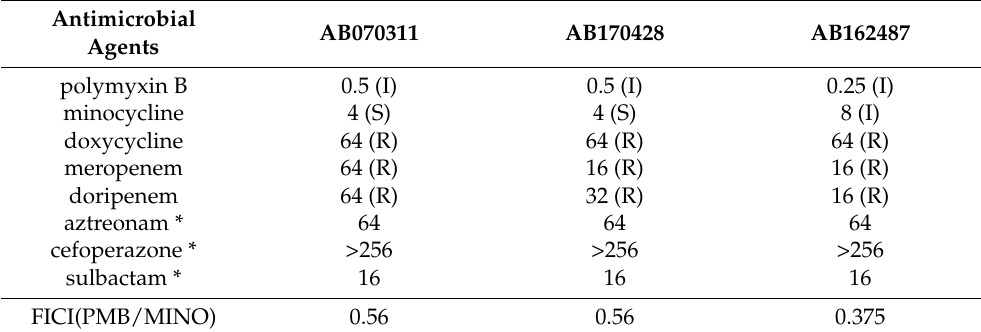
Table 2. MICs and FICI values of tested CRAB